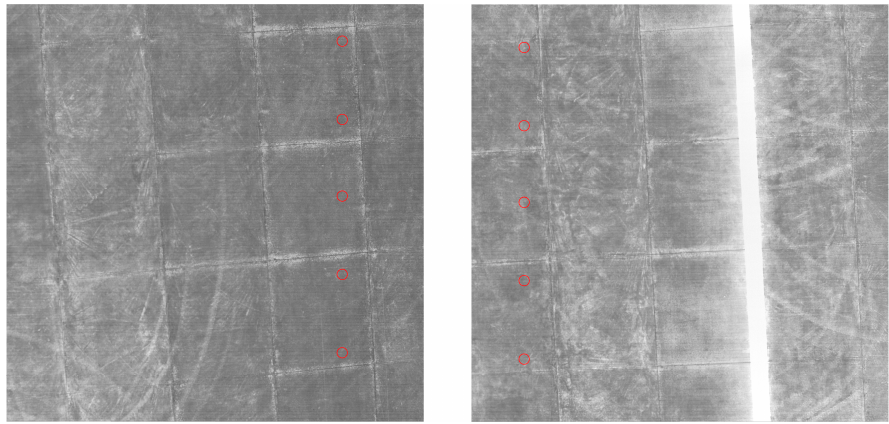
Figure 13. Effect of heterogeneous image registration.